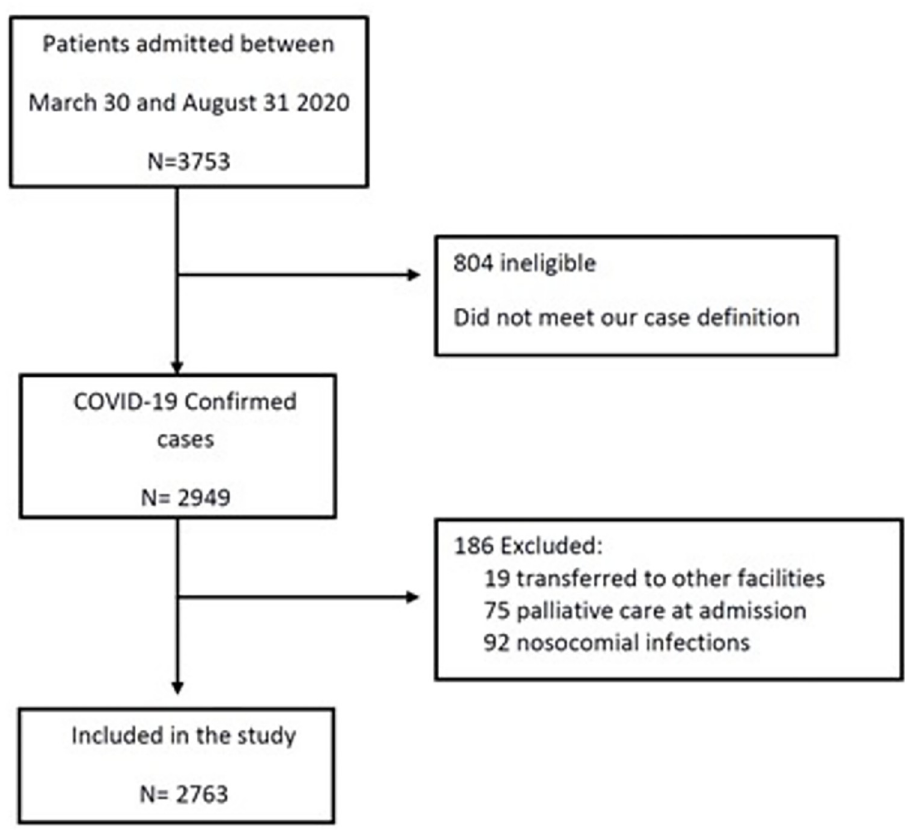
Fig 1. Study participant flow. Flow of potentially eligible participants in the study, and final numbers included and analyzed.